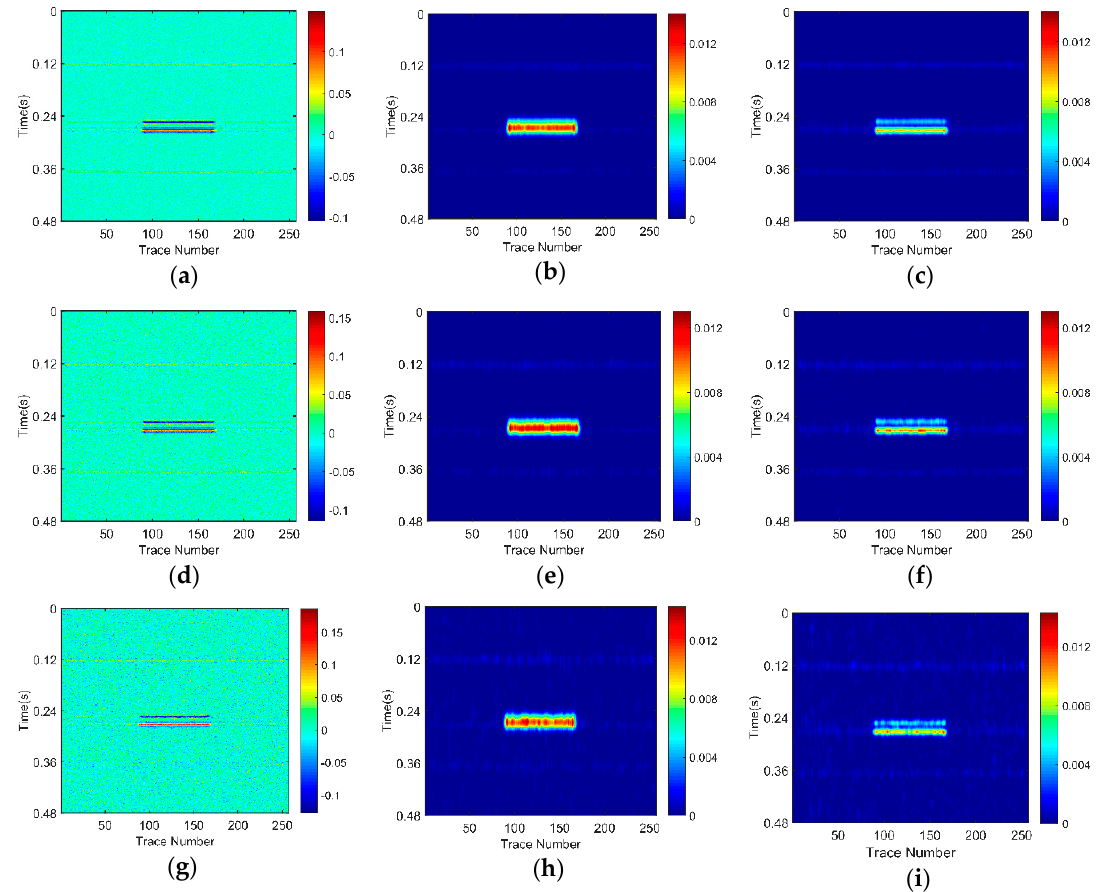
Figure 8. Noisy models and common frequency section of the noisy models: ( a ) noise model 1, SNR = − 2; ( b ) low-frequency section of noise model 1; ( c ) high-frequency section of noise model 1; ( d ) noise model 2, SNR = − 6; ( e ) low-frequency section of noise model 2; ( f ) high-frequency section of noise model 2; ( g ) noise model 3, SNR = − 10; ( h ) low-frequency section of noise model 3; and ( i ) high-frequency section of noise model 3.